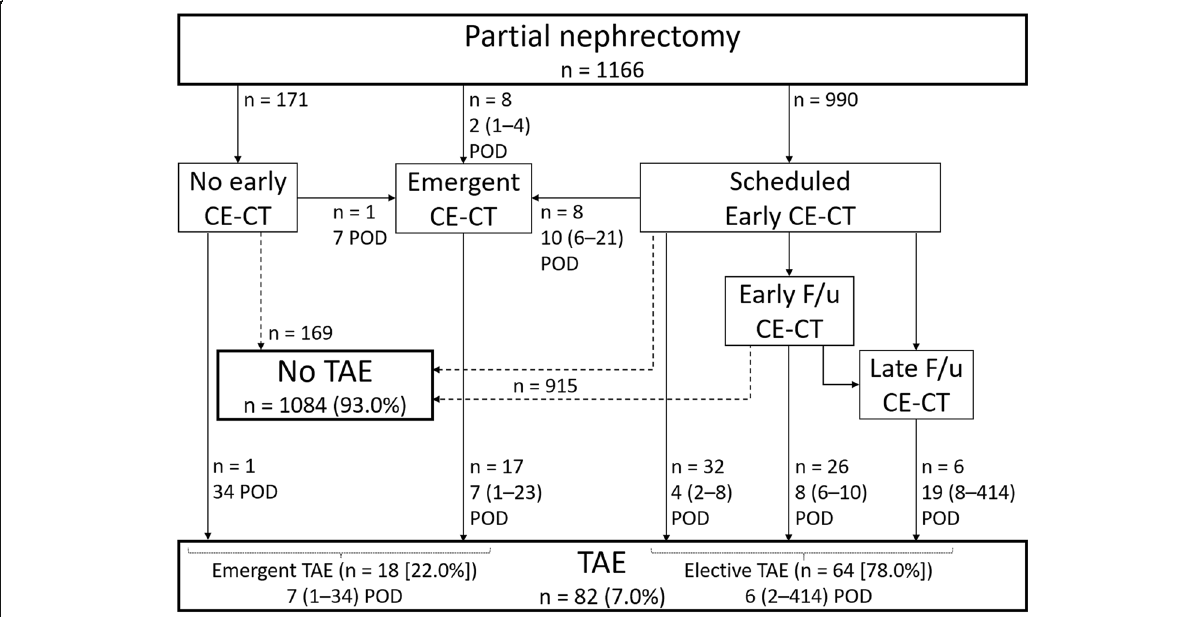
Fig. 1 Flowchart of the allocation of patients for transarterial embolization (TAE). CE-CT = contrast-enhanced CT, POD = postoperative day; median (range), RAP = renal artery pseudoaneurysm, F/u =